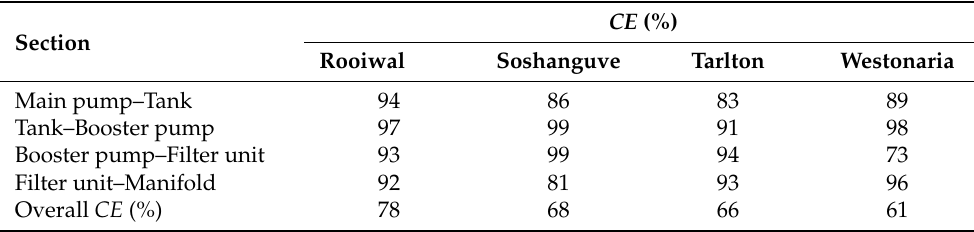
Table 3. Conveyance efficiency ( CE ) for irrigation infrastructure components at the Agri-Parks, Gauteng province (February–March 2021).